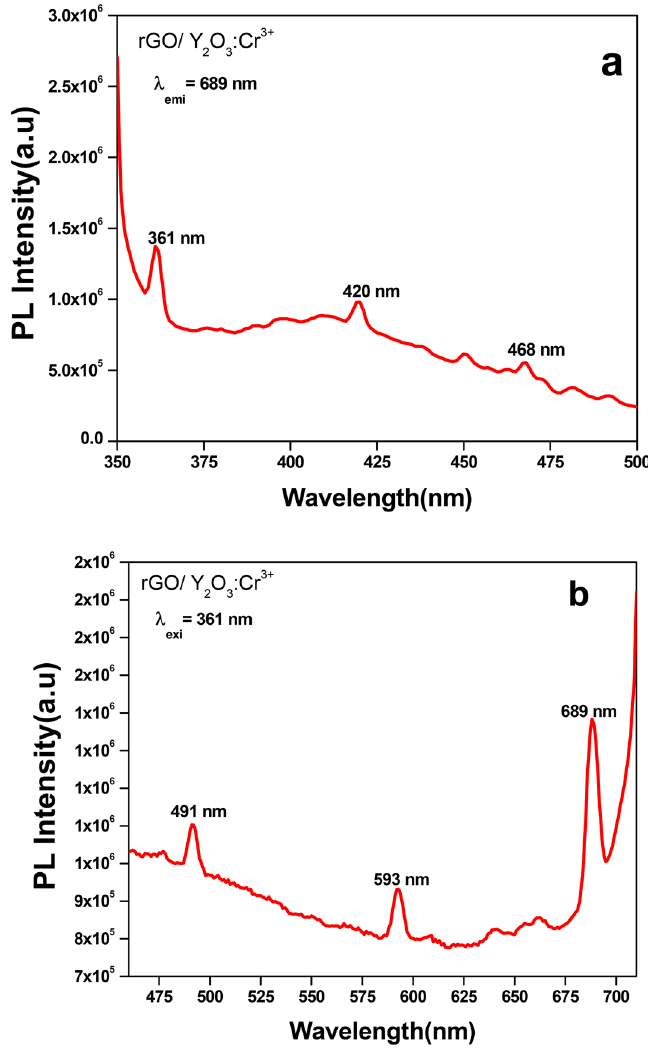
Figure 3. (a) PL excitation spectrum, ( b) emission spectrum of rGO/Y 2 O 3 :Cr 3+ NCs.